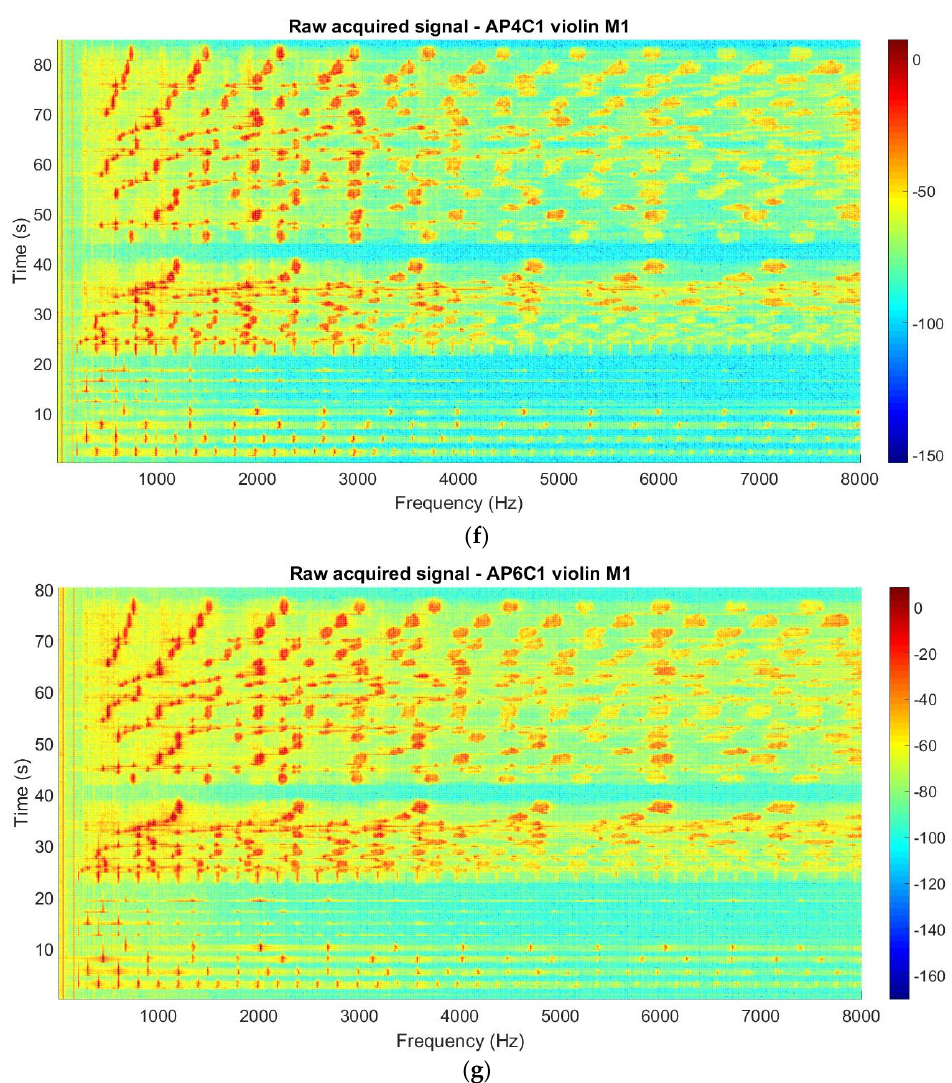
Figure 6. The acoustic spectrograms of musical sequences for each studied violin: ( a ) AM6C1; ( b ) AM4C1; ( c ) AM2C1; ( d ) A00C1; ( e ) AP2C1; ( f ) AP4C1; ( g ) AP6C1.